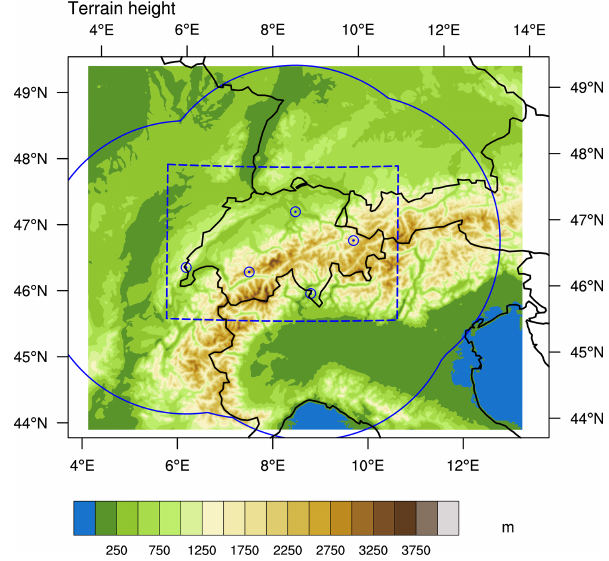
Figure 2. As for Fig. 1, but for the inner (higher-resolution) nested WRF domain.